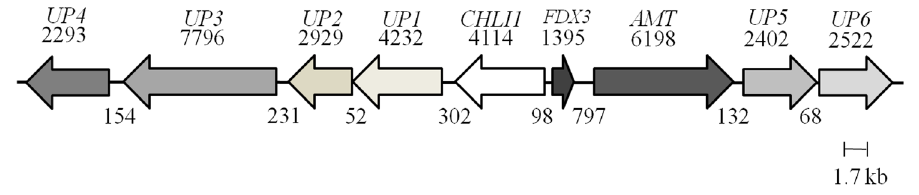
Figure 5. A schematic map of the UP6 locus on chromosome 6. The map shows a 35.7 kb genomic DNA region that harbors the UP6 and eight genes located upstream of it. Each arrow represents a gene. The name of the gene is given on top of the arrow. The black numbers on the top of arrows denote sizes of genes (bp) while black numbers below denote distances in between genes